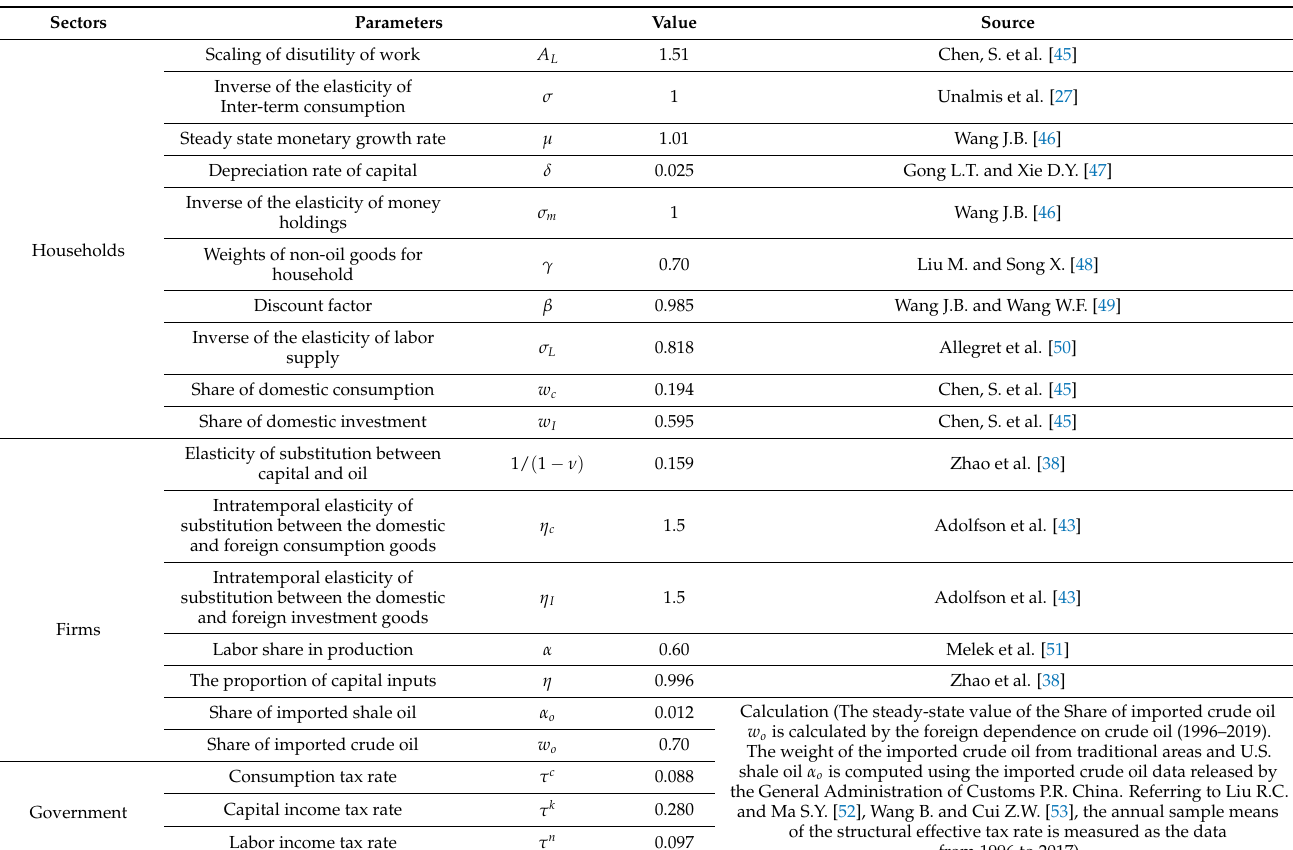
Table 2. Calibrated